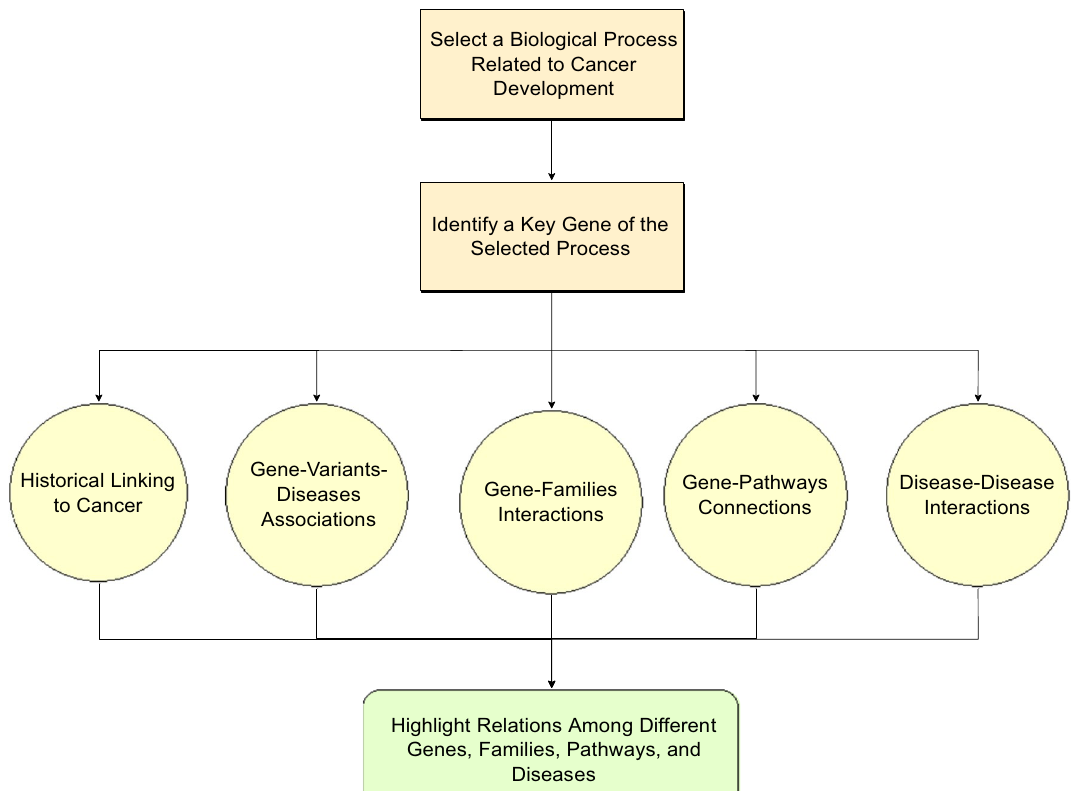
Figure 11. The block diagram depicting the work flow of the conducted